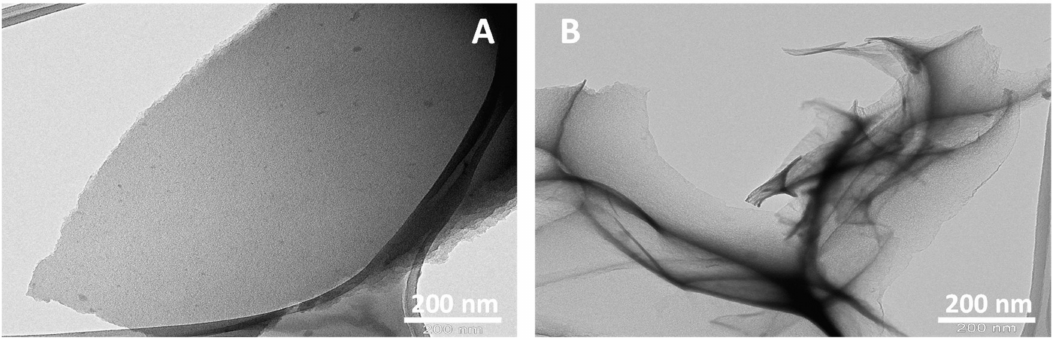
Figure 6. TEM micrograms obtained for graphene sheets-like structure of ( A ) PPy/Ar-1 ( B )